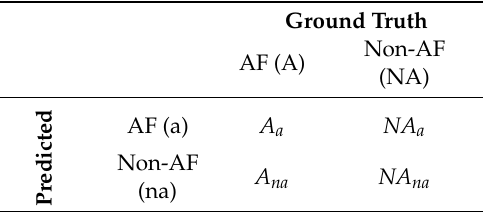
Table 3. Confusion matrix of two classes.